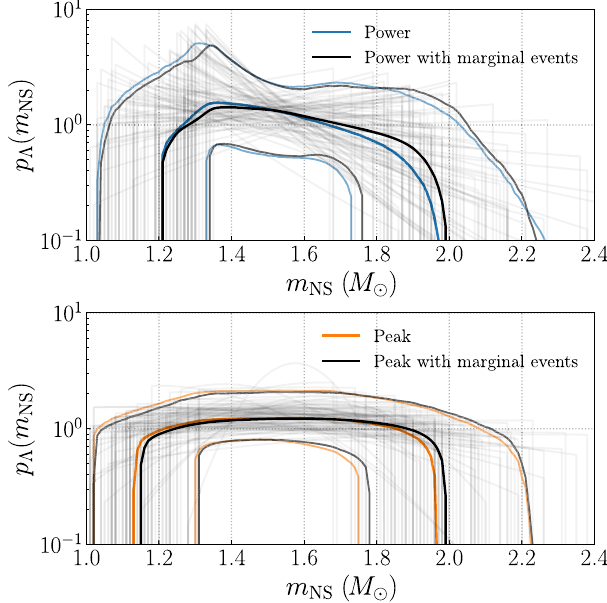
FIG. 25. Inferred neutron star mass distribution with and without the marginal events GW190426 and GW190917. Top: median and 90% confidence region of the inferred NS mass distribution for the P OWER model, using the event list at a FAR threshold of 0 . 25 yr − 1 (blue) and 1 yr − 1 (orange). Traces from the posterior population distribution with respect to the stricter FAR threshold are plotted in gray. Bottom: same as the top panel but for the P EAK model. The inclusion of the marginal events has a negligible impact on the inferred mass